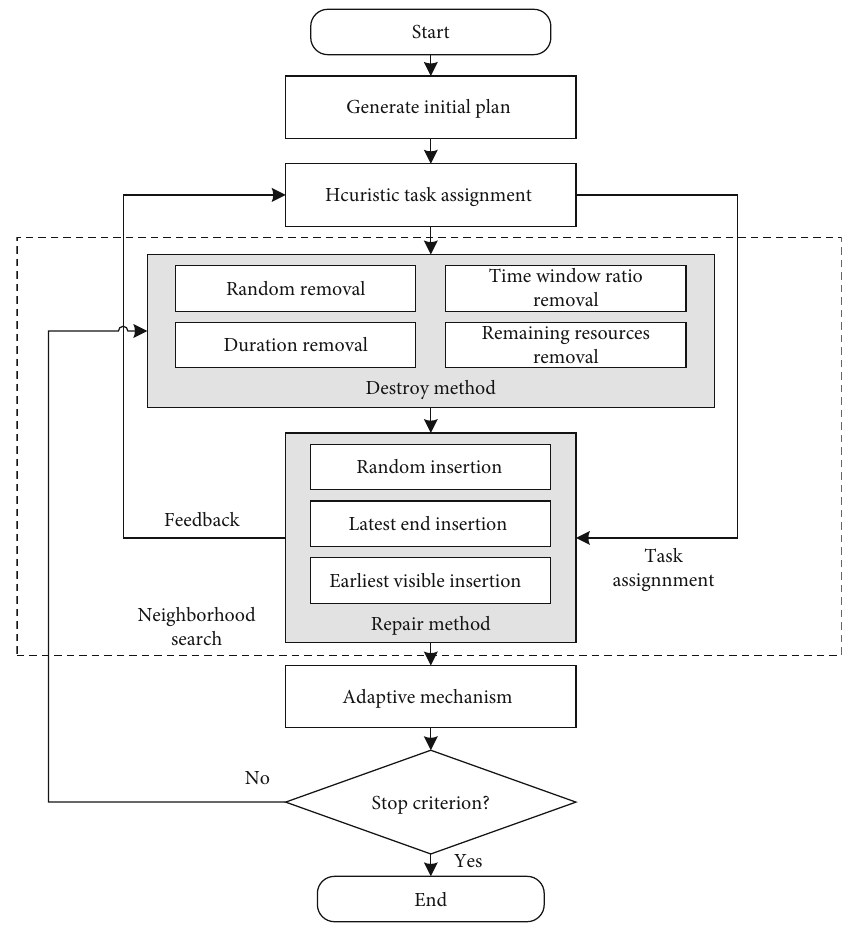
Figure 1: H-ALNS fl ow